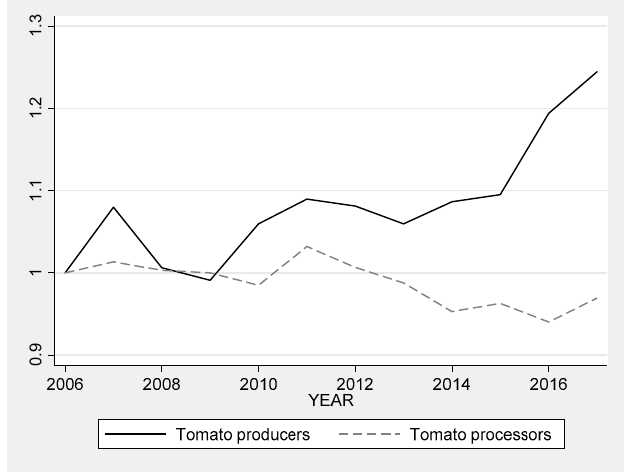
Figure 8. TFP growth in tomato production and processing (2006=100). Source: authors’ calculations.